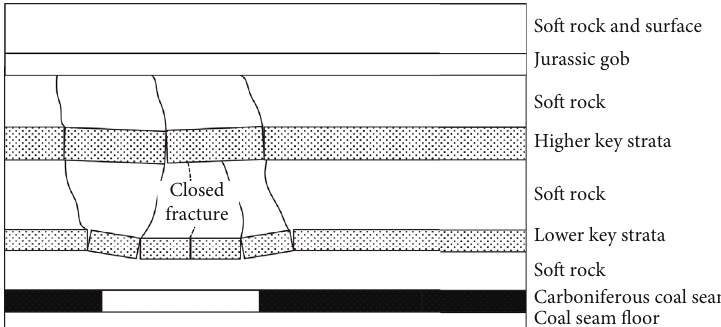
Figure 9: Distribution diagram of gas-conducting fracture fi eld in the fi rst fracture of the higher key strata.